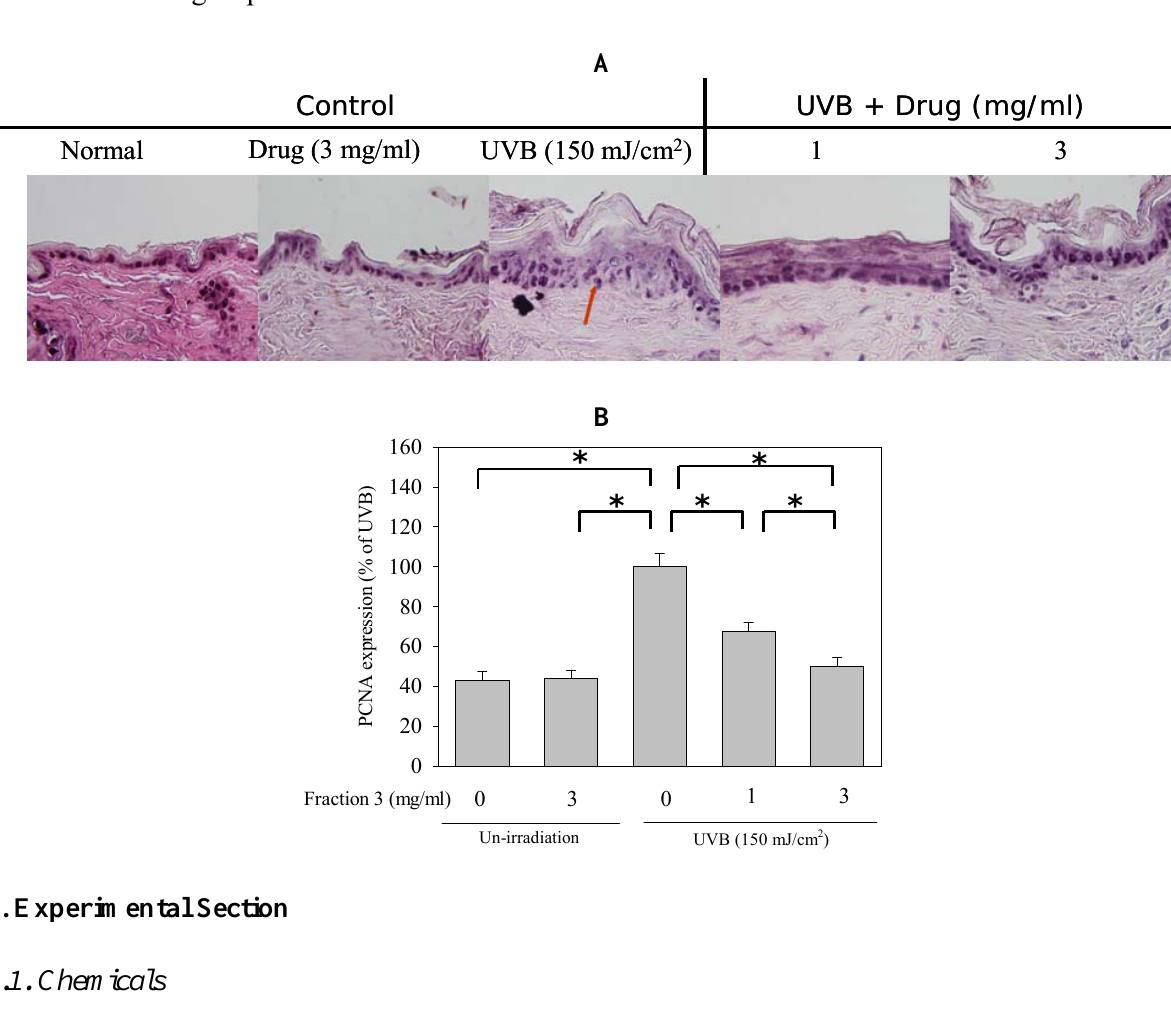
Figure 7. Fraction 3 inhibits UVB irradiation increased PCNA expression. ( A )